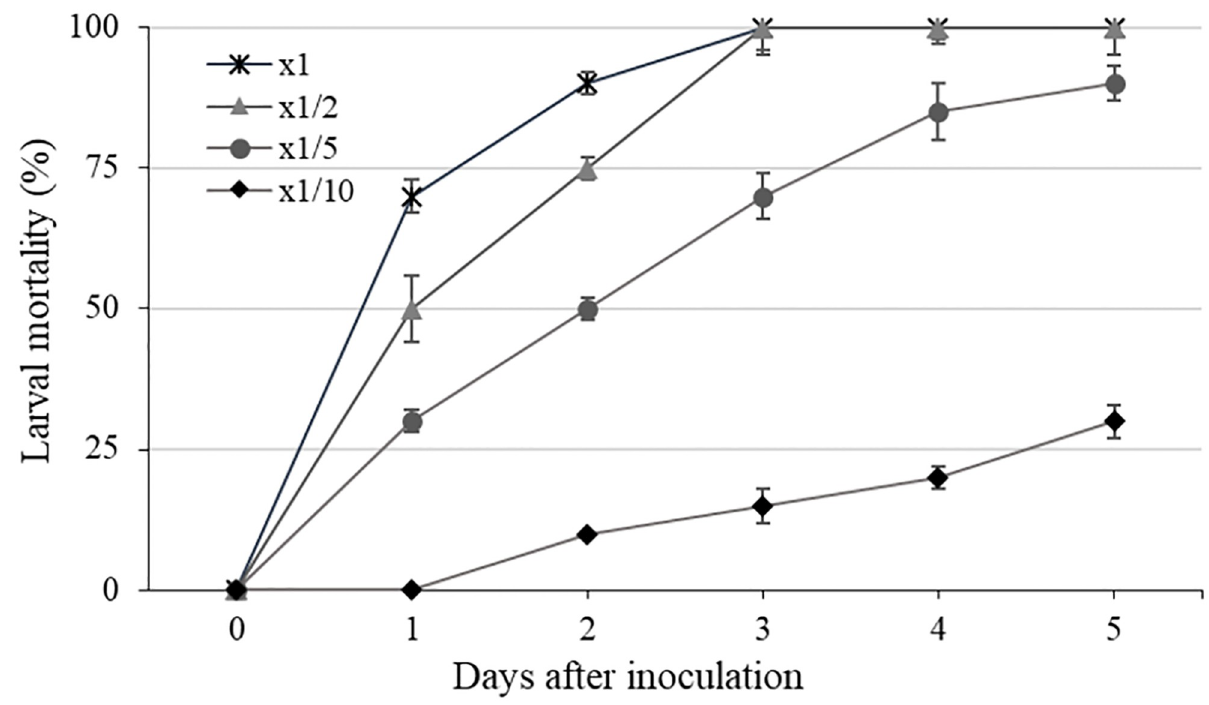
Fig 2. Concentration-dependent insecticidal activities of KR0006 against Plutella xylostella . The 10mL diluted solutions of the KR0006 were sprayed on the foliage of Chinese cabbage (2 plants) growing in the greenhouse. Plants were inoculated with P . xylostella 2 nd instars (10 larvae/plant) and the mortality was calculated five days after inoculation. The vertical bars indicate the standard errors of the means.